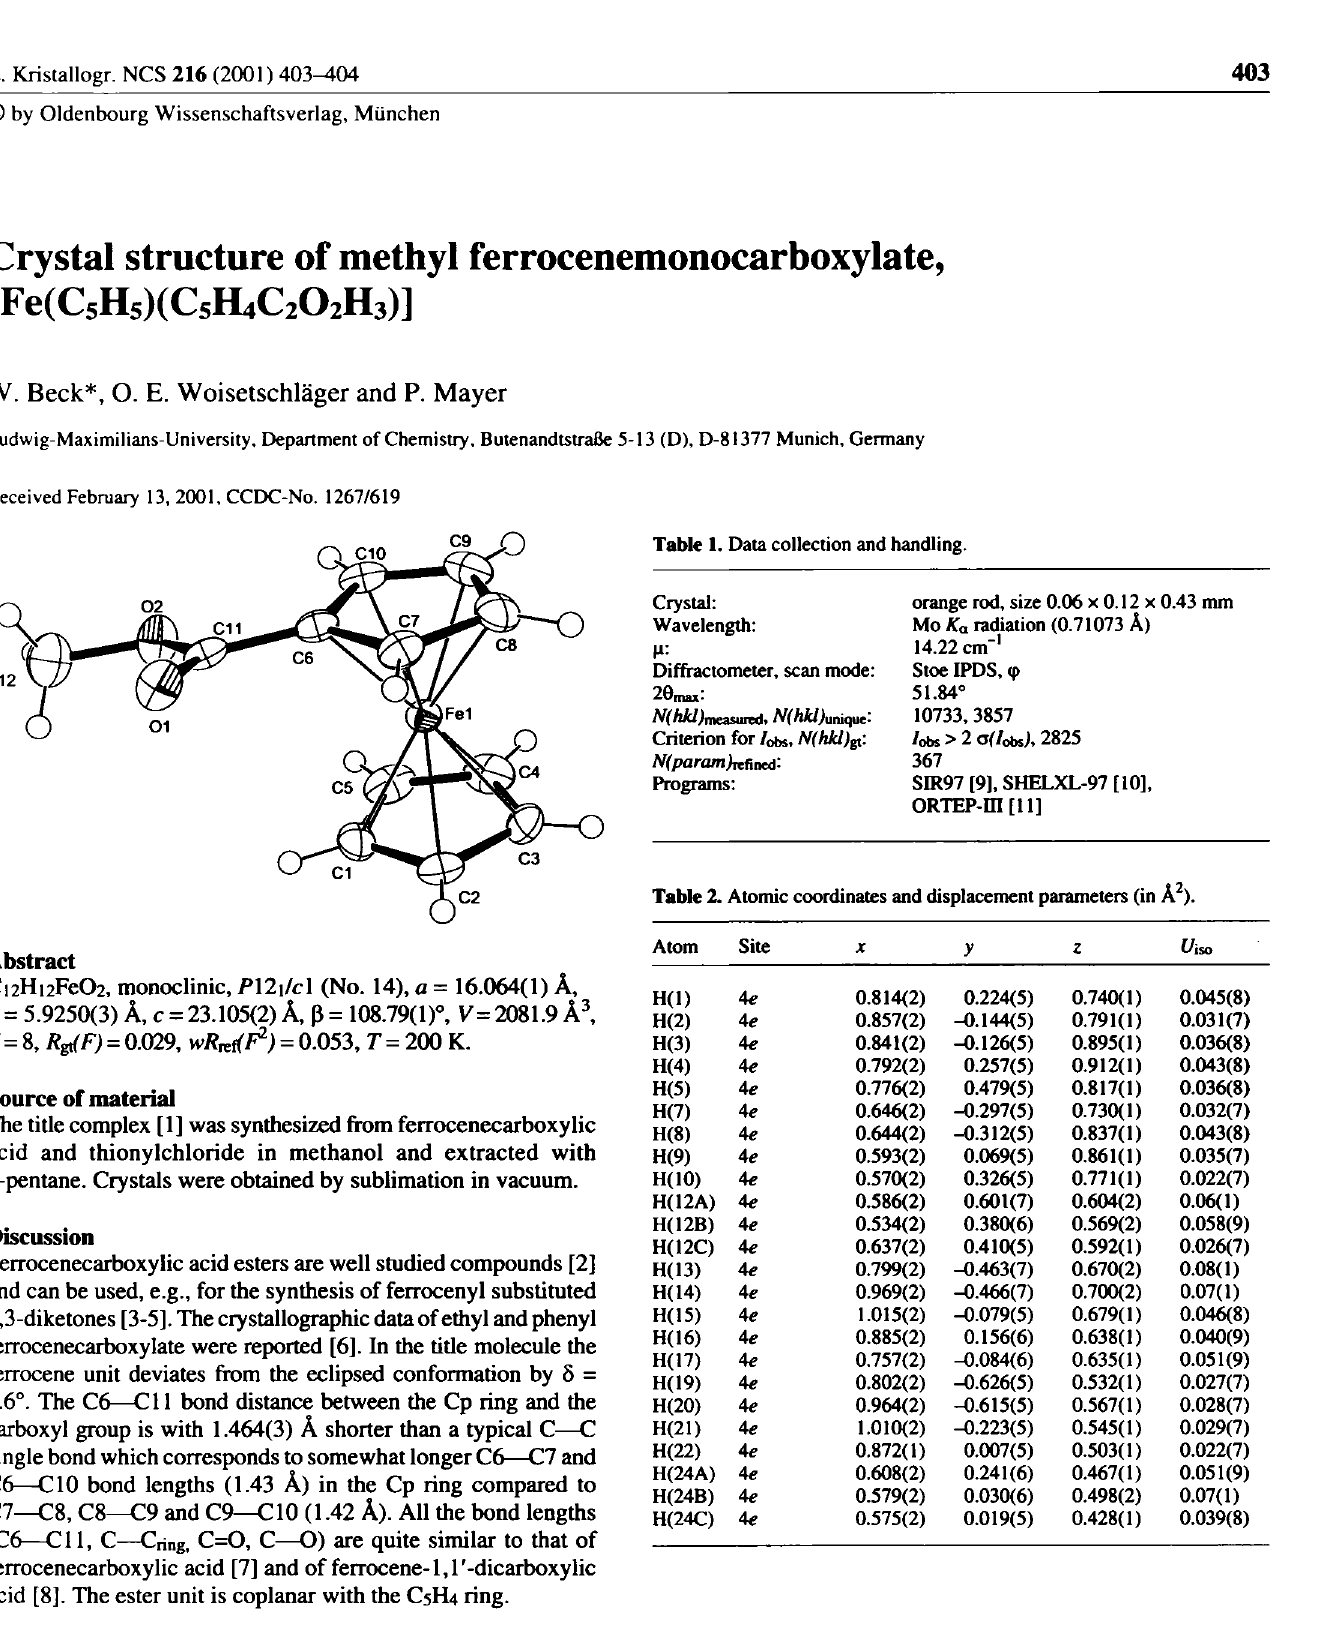
Table 2. Atomic coordinates and displacement parameters (in A 2